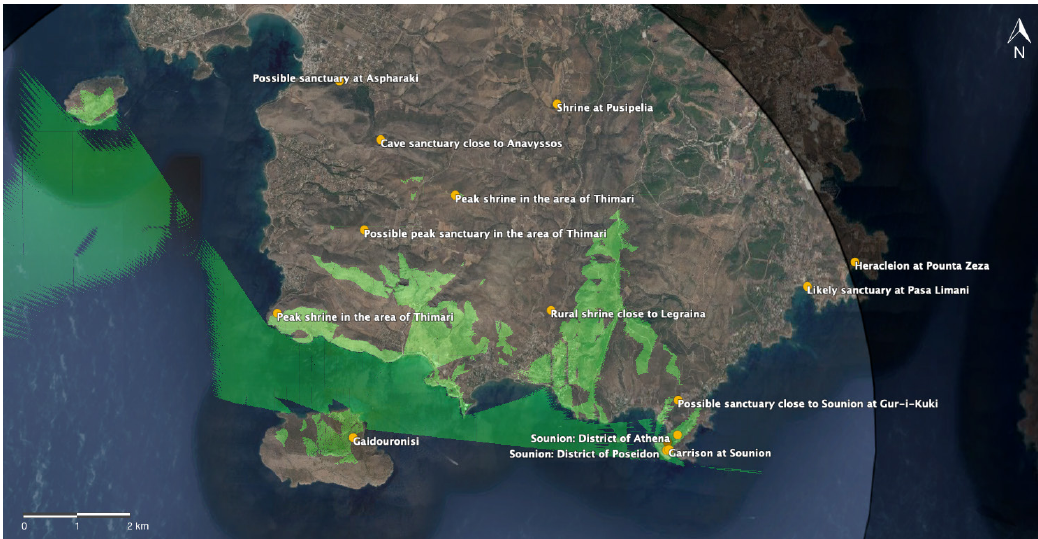
Figure 4. View shed analysis: areas visible from Patroklos Island/Gaidouronisi (M.